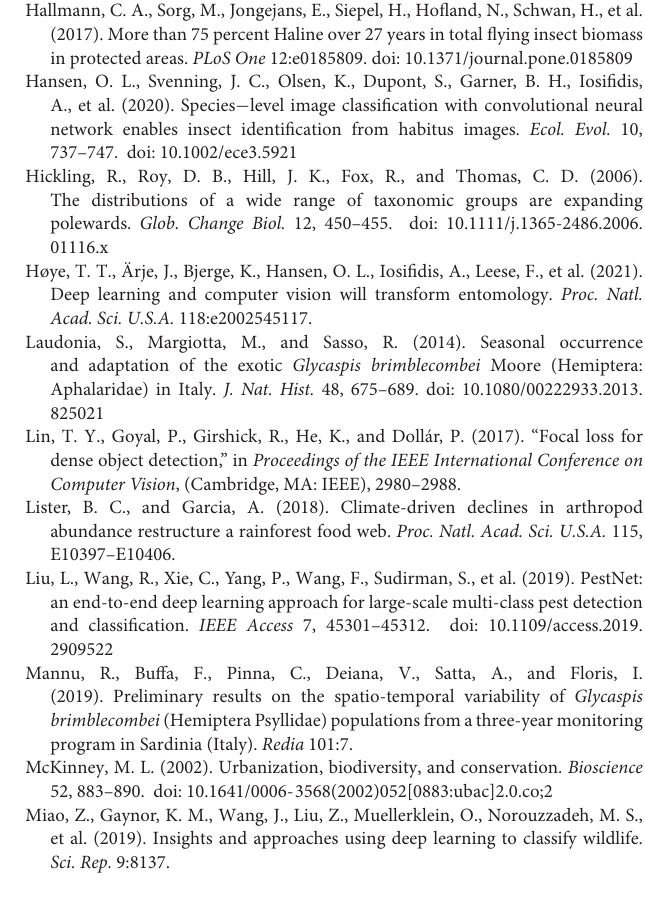
Supplementary Figure 1 | The model’s loss function ( Figure 2 left panel) is a sum of three components, each of which penalizes a different type of prediction error: incorrectly placed bounding boxes (left panel), failures in detecting an object (center panel), and failures in correctly identifying it (right panel). All three components decrease during training and